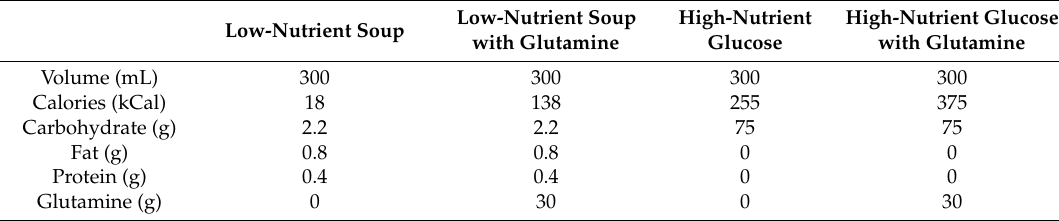
Table 1. Components of the four study drinks. The low-nutrient soup drink was derived from Continental ® beef stock cubes (Unilever Australasia Ltd., Epping, NSW, Australia) made up to 300 mL with water [32]. The high-nutrient dextrose drink was derived from 75 g of D-(+)-Glucose monohydrate, Fluka (Sigma-Aldrich ® Pty Ltd., Castle Hill, NSW, Australia) made up to 300 mL with water [32]. Low-Nutrient Soup High-Nutrient High-Nutrient Glucose Low-Nutrient Soup with Glutamine Glucose with